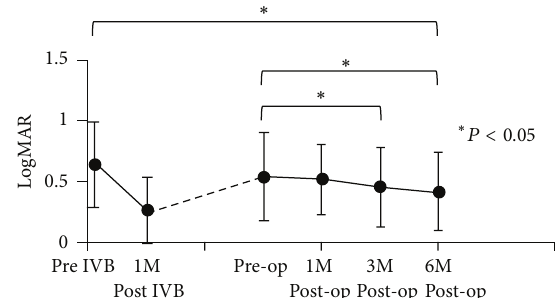
Figure 1: Changes in mean best corrected visual acuity. Mean BCVA was significantly improved after 1 month of IVB compared to the baseline. Mean BCVA was significantly improved at 3 months and 6 months after vitrectomy, compared to the preoperative mean BCVA ( ∗ 𝑃 < 0.05 ). BCVA: best corrected visual acuity; IVB: intravitreal injection of bevacizumab; post IVB: 1 month after IVB.